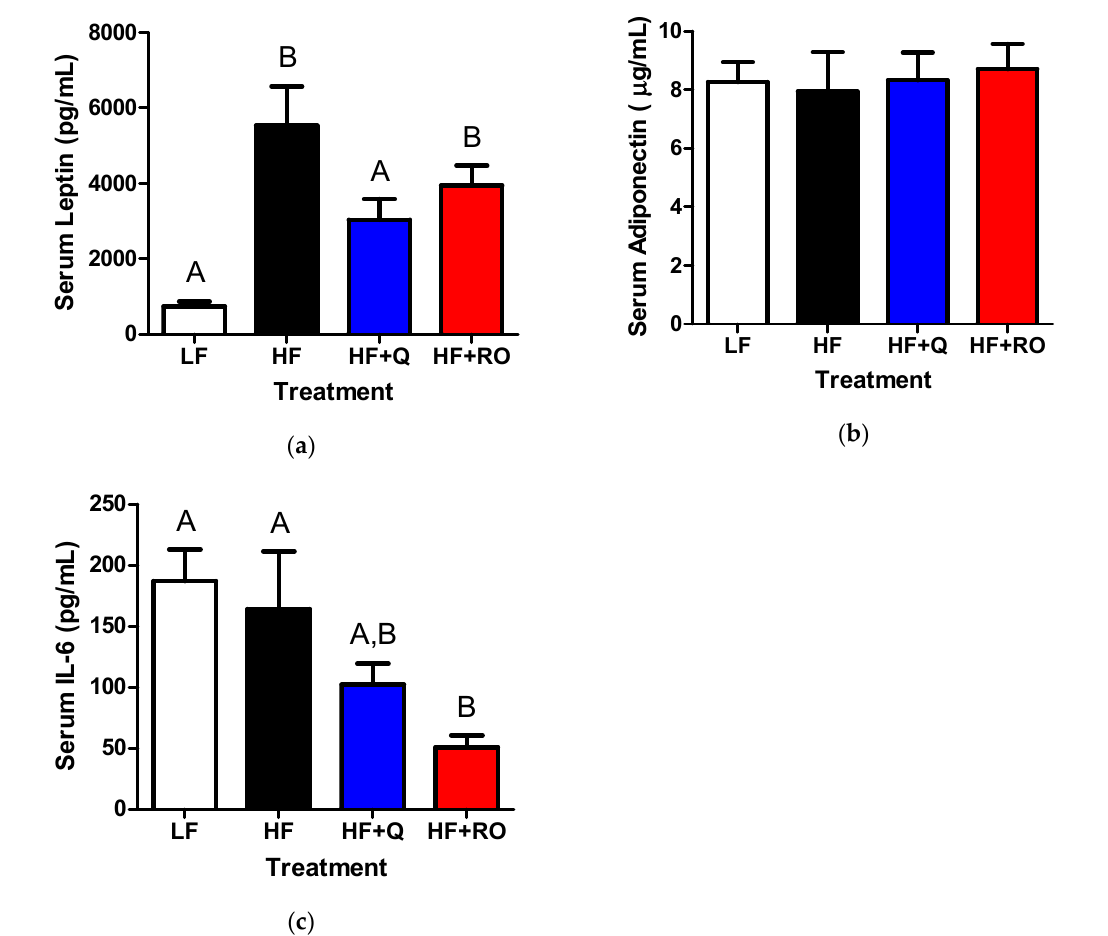
Figure 6. Serum levels of ( a ) leptin ( b ) adiponectin and ( c ) IL-6 were determined in serum from mice were fed low fat (LF; white), high fat (HF; black), high fat + quercetin (HF + Q; blue) or high fat + ROE (HF + RO; red) diets and graphs of respective means ± SEM are shown. Different letters denote significant differences between groups at p <0.05. A is the protein leptin. B is adiponectin and C is IL-6.